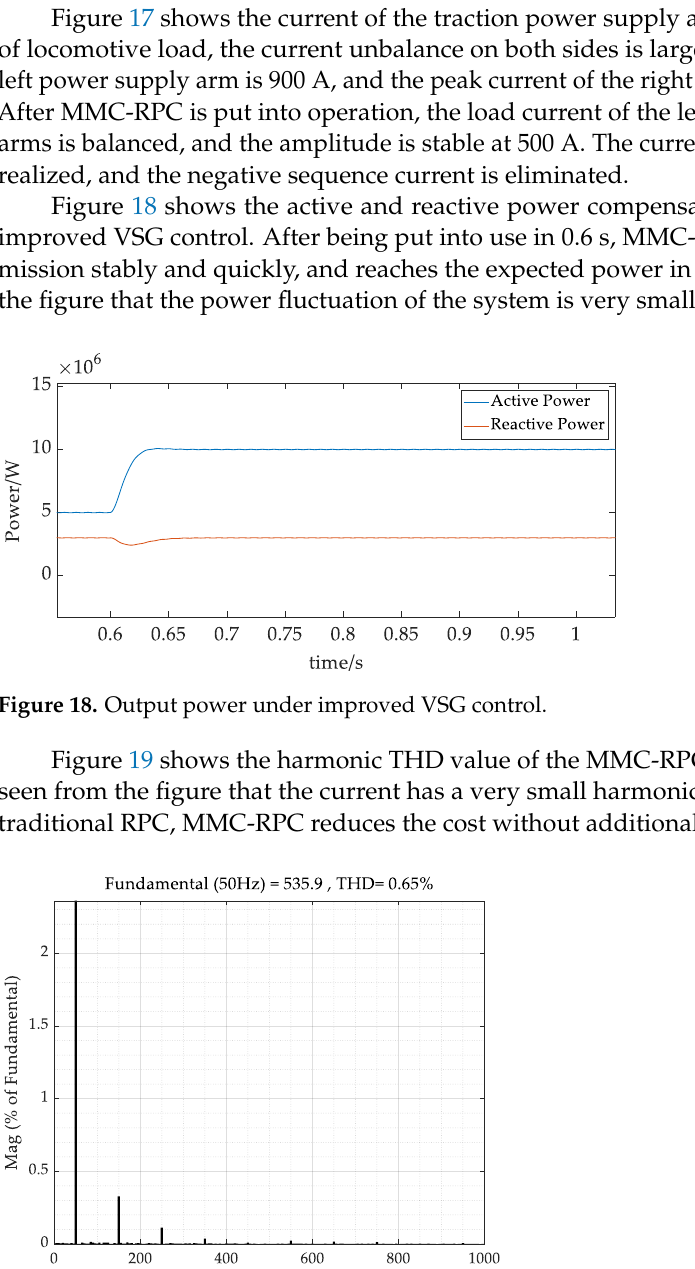
Table 1. Traction network parameters.